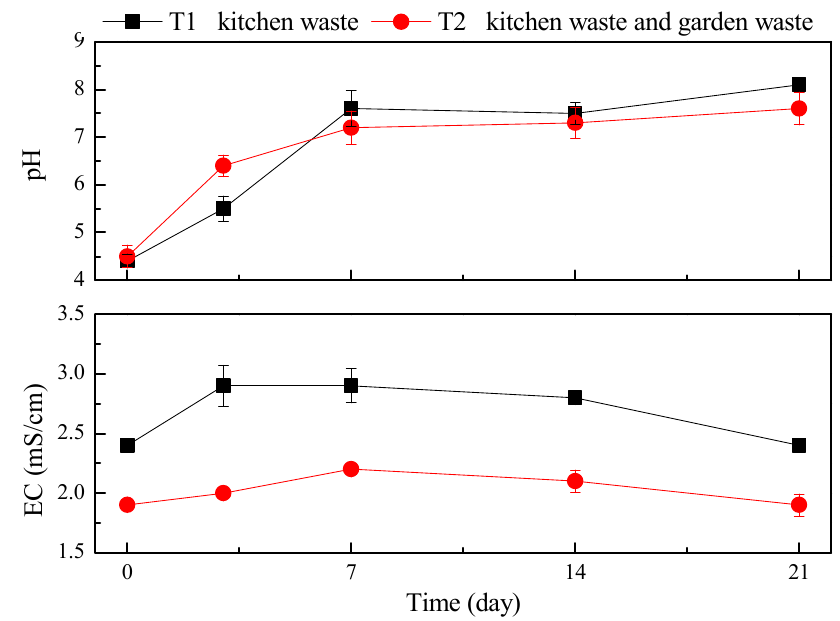
Figure 3. Evolution of pH and EC during composting.